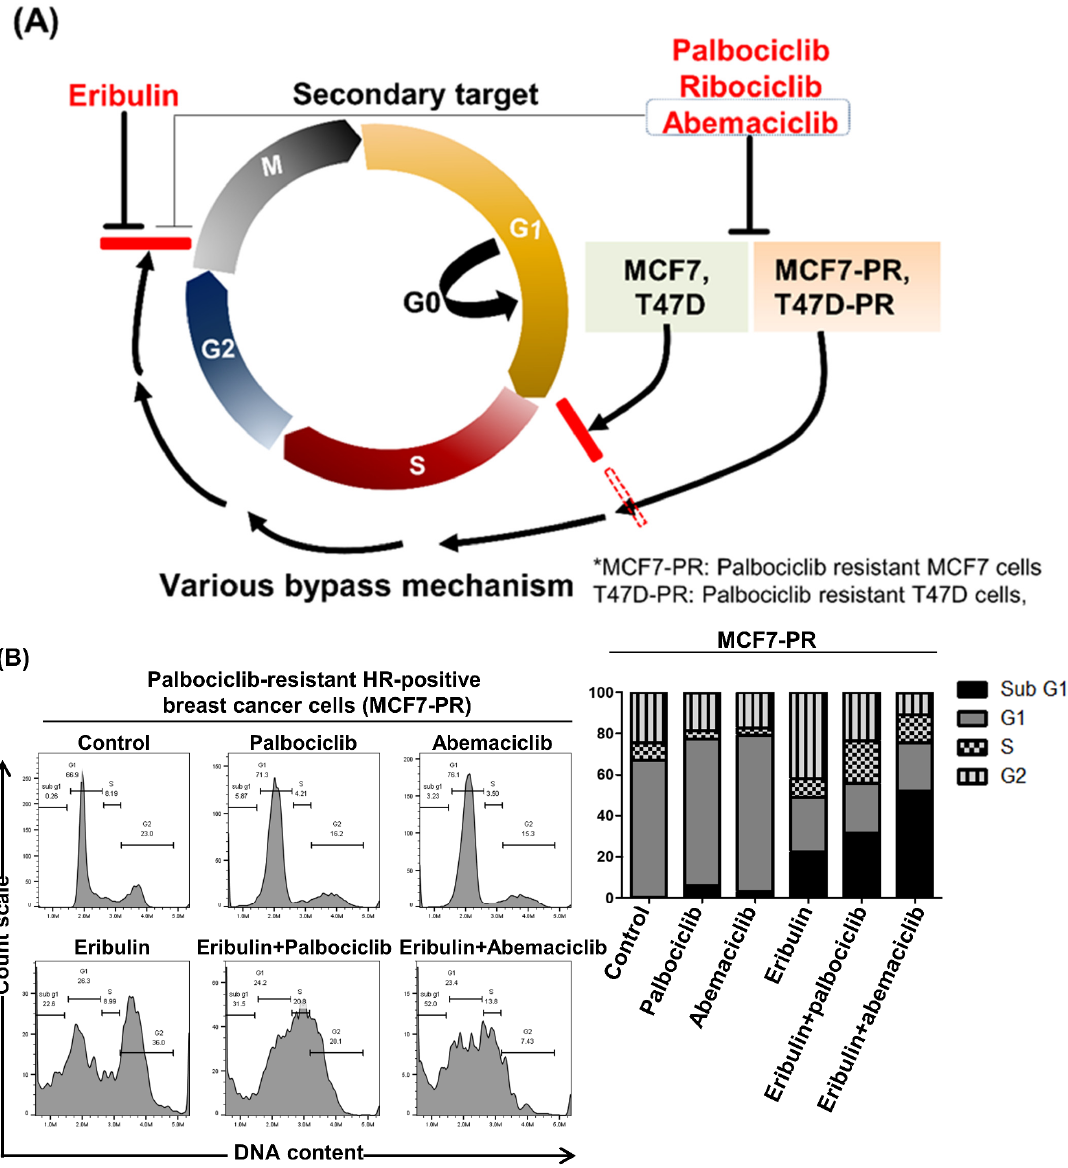
Figure 1. ( A ) Schematic figure demonstrating the escaping palbociclib-resistant cells, MCF7-PR and T47D-PR, via various bypass mechanisms. Mitosis of the aforementioned cells could be blocked by eribulin at the G2/M phase. ( B ) MCF7-PR cells were treated with IC25 concentration of eribulin, palbociclib, or abemaciclib and their combinations for 24 h. Eribulin and palbociclib or eribulin and abemaciclib combinations treatment was sequentially performed without a time gap be- tween the drugs. Cell cycle distribution comparing the efficacy of palbociclib to abemaciclib after combination with eribu- lin was analyzed by flow cytometry. HR hormone